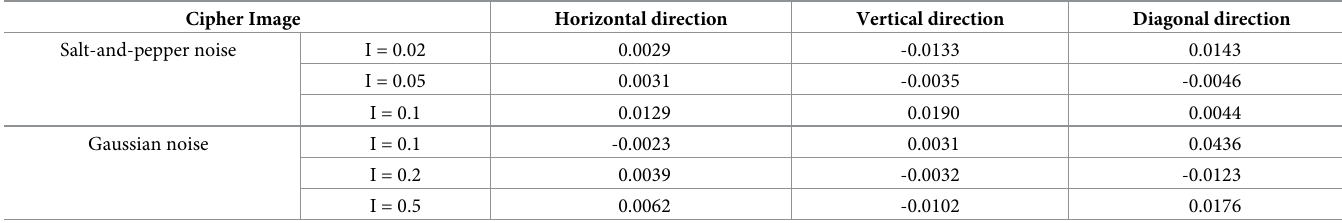
Table 10. Correlation between adjacent pixels of noisy